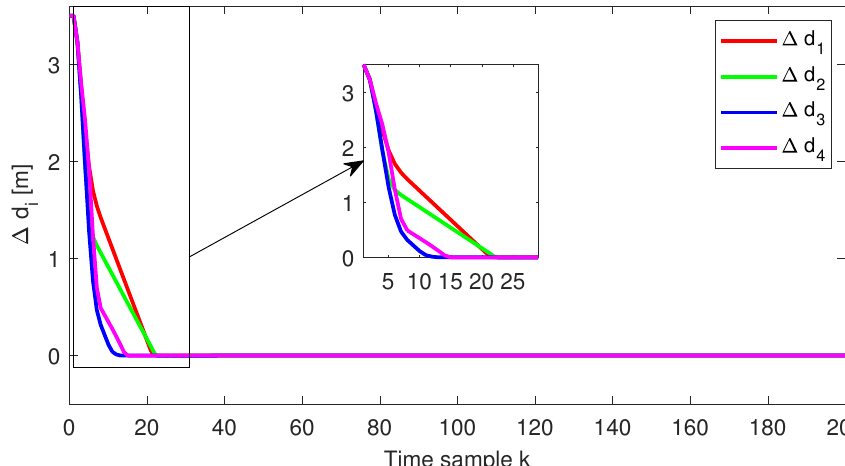
Figure 4. Test 4 —Distance error for each platoon vehicle.